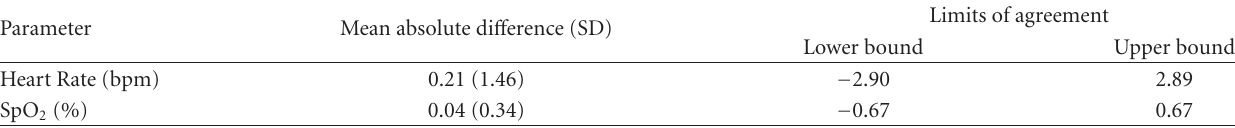
Table 1: Statistical comparison between data logged at the participant (local) and therapist (remote) sites.